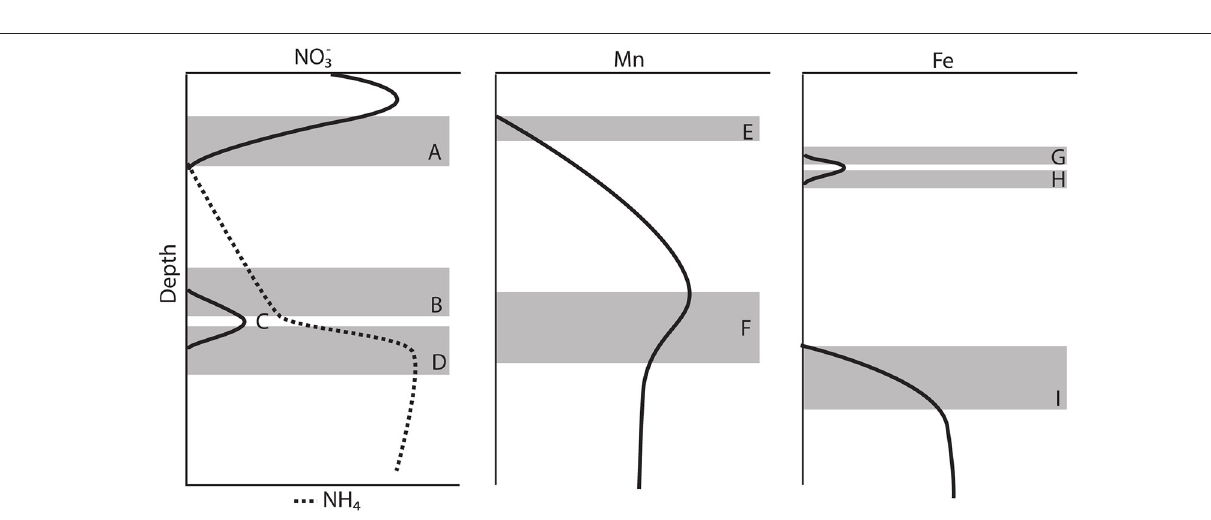
Fan (5.14 ◦ N 46.57 ◦ W, 3511 m depth), where dissolved Mn +